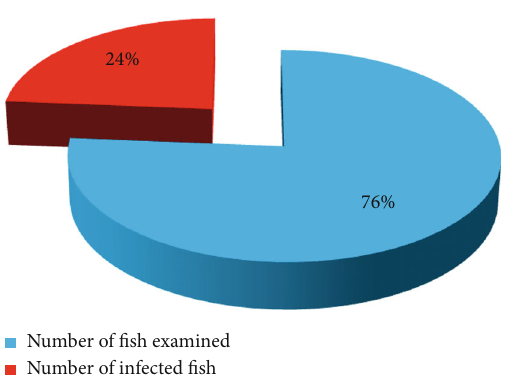
Figure 1: Infected fi sh among fi sh examined in the Atlantic and Mediterranean